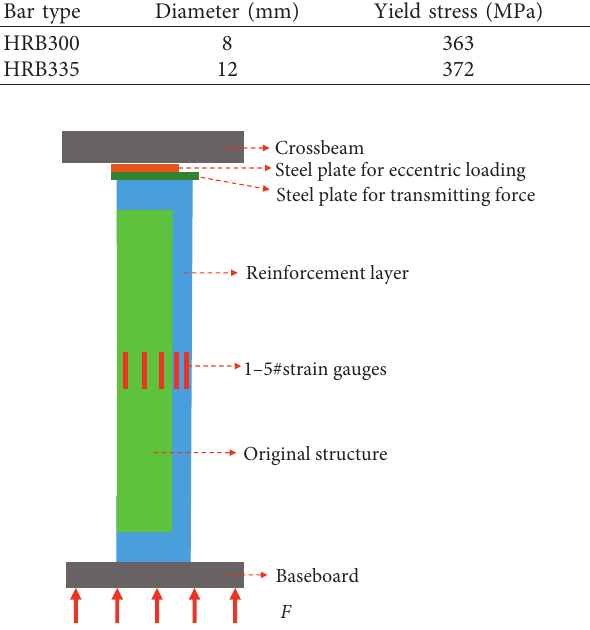
Figure 4: Segment model experimental setup.